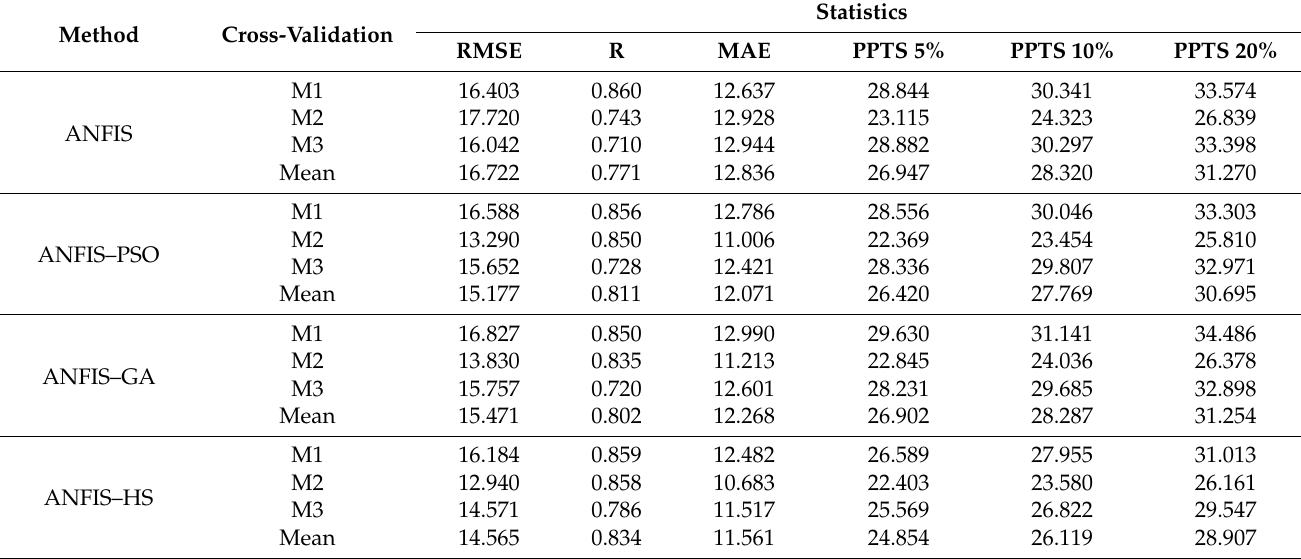
Table 6. Comparison of the applied models with AMM, TKN, WT, and TC as